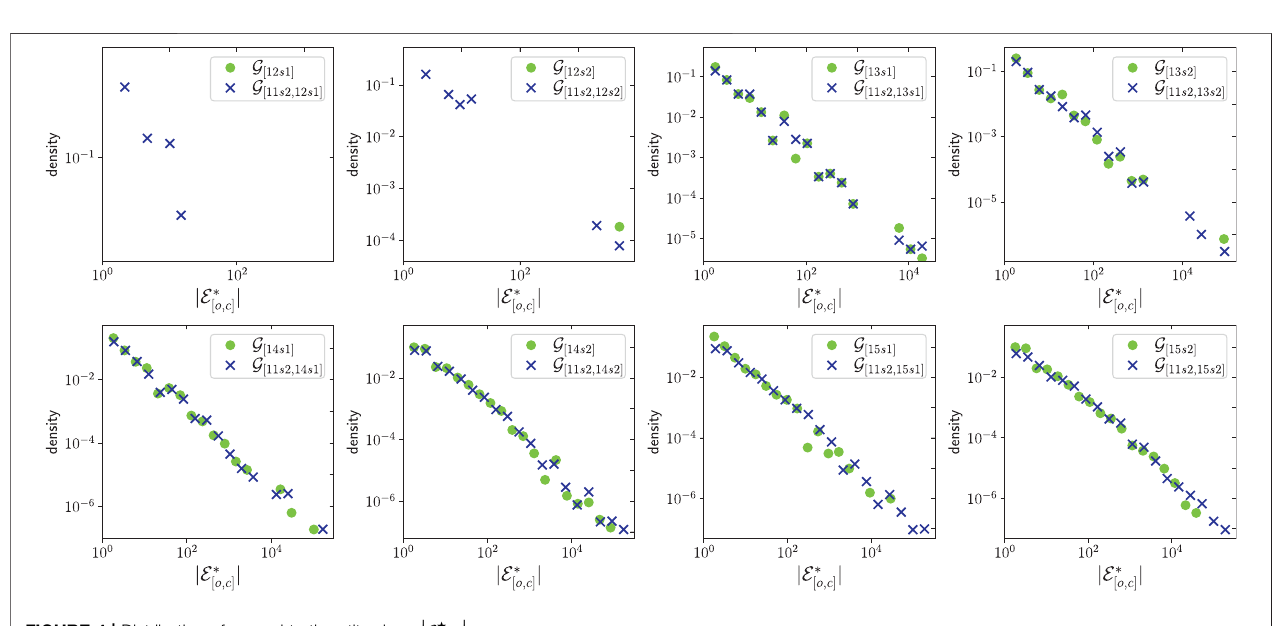
FIGURE 4 | Distribution of ground truth entity sizes,